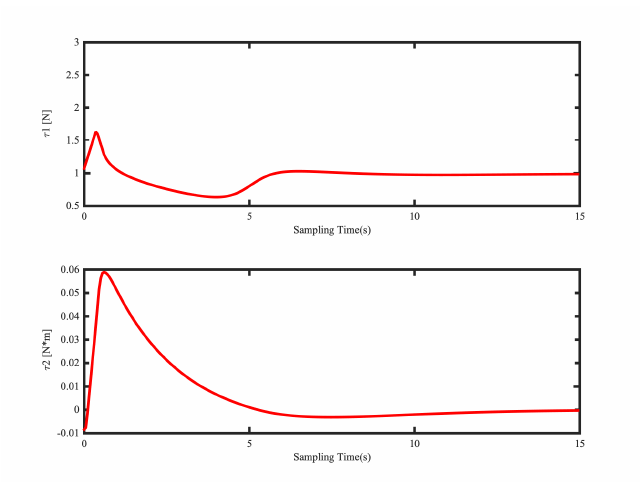
Figure 7. The state errors of the biomimetic spherical robot-Case I.